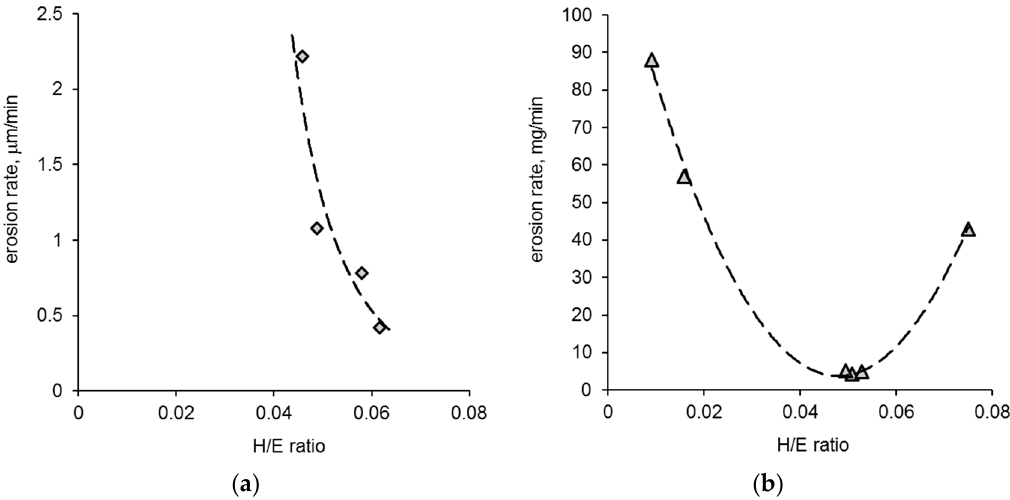
Figure 15. Relation between H/E ratio and erosion rate of various PVD coatings, performed on the basis of on data from ( a ) Reference [120], ( b ) Reference [110].